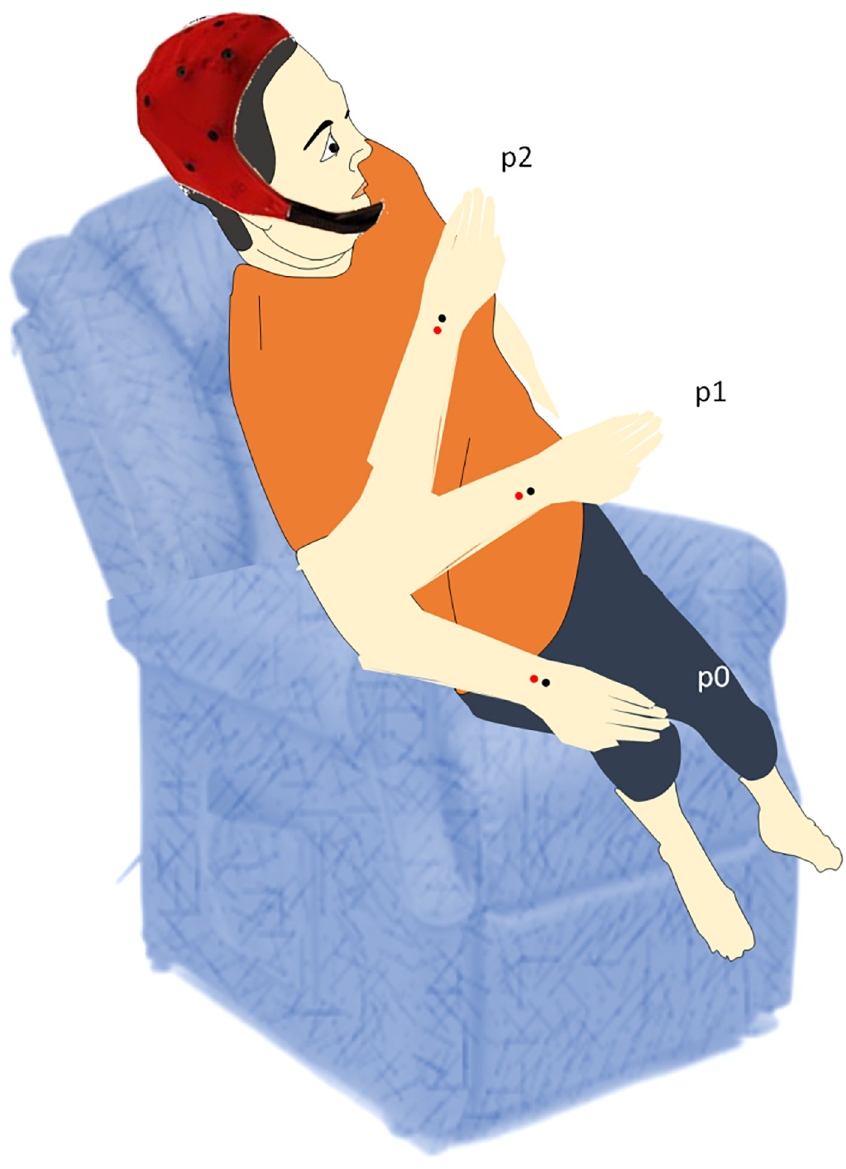
Fig 1. Experimental